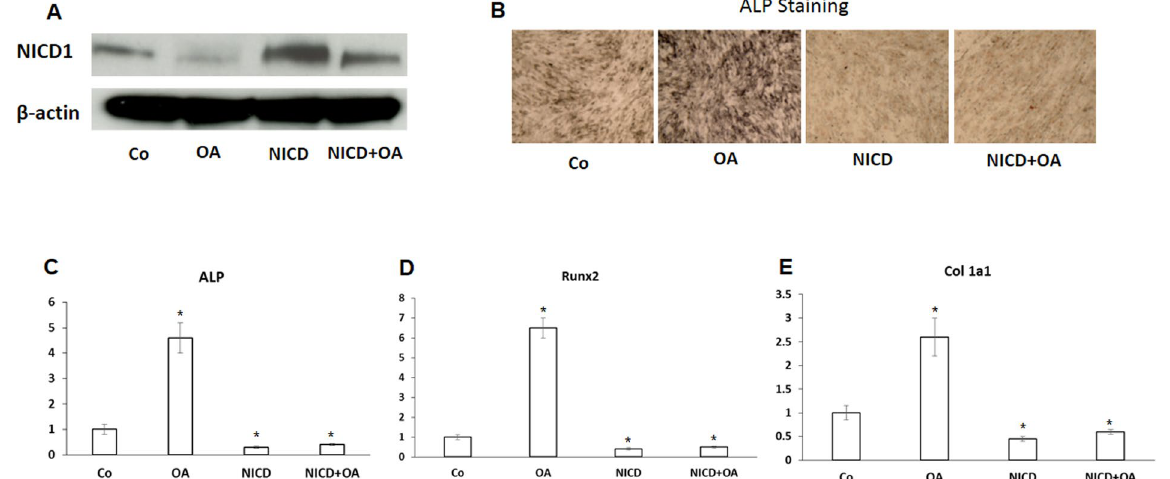
Figure 2. Notch signaling blocks OA-induced osteogenesis in MSC culture. NICD1 lentivirus infected MSCs were treated with OA before being harvested for western blot, ALP staining, and RT-PCR analysis. ( A ) Western Blot showed a significant increase of NICD protein expression at day 3 following NICD1 lentiviral infection. Full-length blots/gels are presented in Supplementary Figure S1. ( B ) Overexpression of NICD1 resulted in decreased ALP staining at day 7, compared to GFP-lentirvirus infected controls (Co). (Magnification: × 5). ( C , D , E ) Real time PCR data showed a significant increase of ALP, Runx2, Col1a1 expression at day 7 following OA treatment and these induced expression was significantly reduced by NICD1 lentiviral infection compared to GFP-lentirvirus infected controls (Co). Data is the means ± s.d. of three independent experiments performed in duplicate and the control gene expression level at day 7 was set at 1 ( * p < 0.05 compared with control).